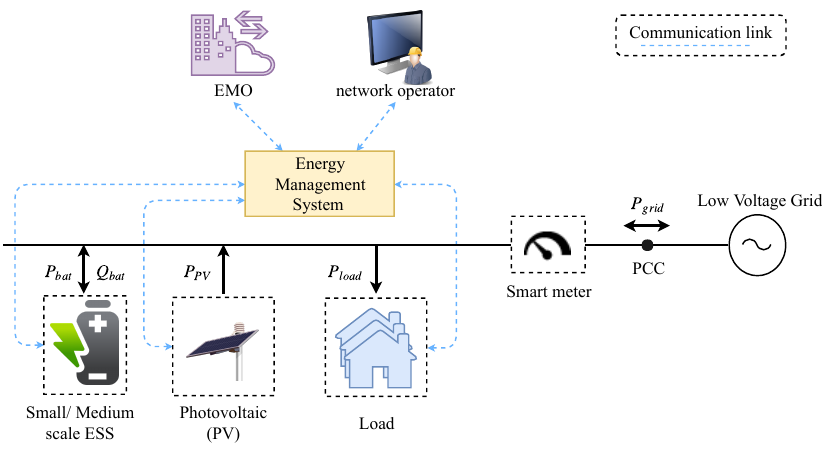
Figure 1. EMS setup with corresponding communication architecture. Table 1. Use cases derived from the integration of BESS into a low voltage